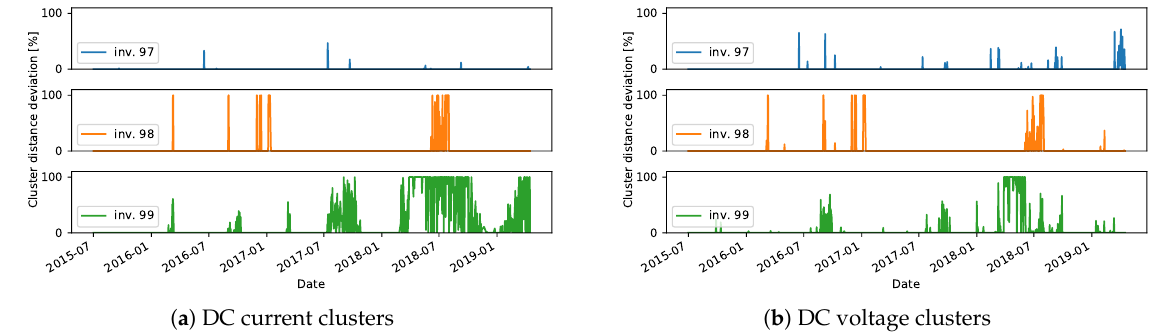
Figure 13. Unusual day event detection in plant B.